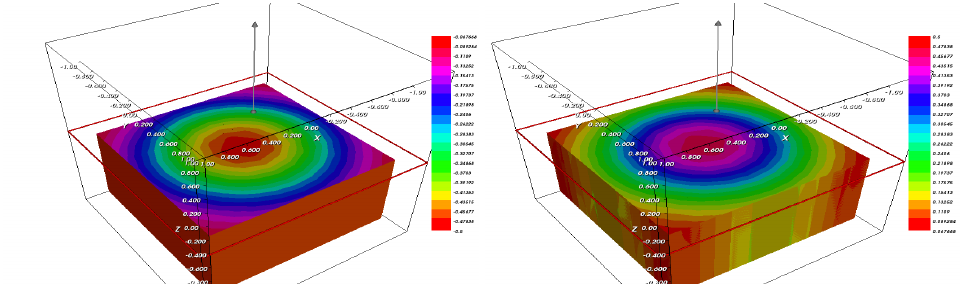
Figure 1. The fraction ϕ ( left ), and ψ ( right ) after T = 0.